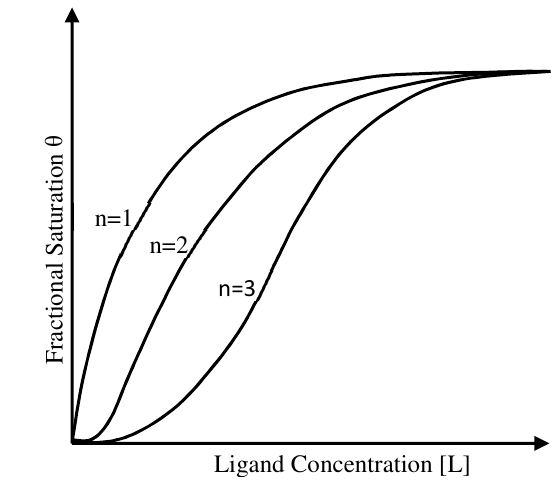
Fig.1: Hill Function Sigmoidal Curves. Fractional saturation θ plotted against Ligand Concentration (cid:8)L(cid:11) for different values of n